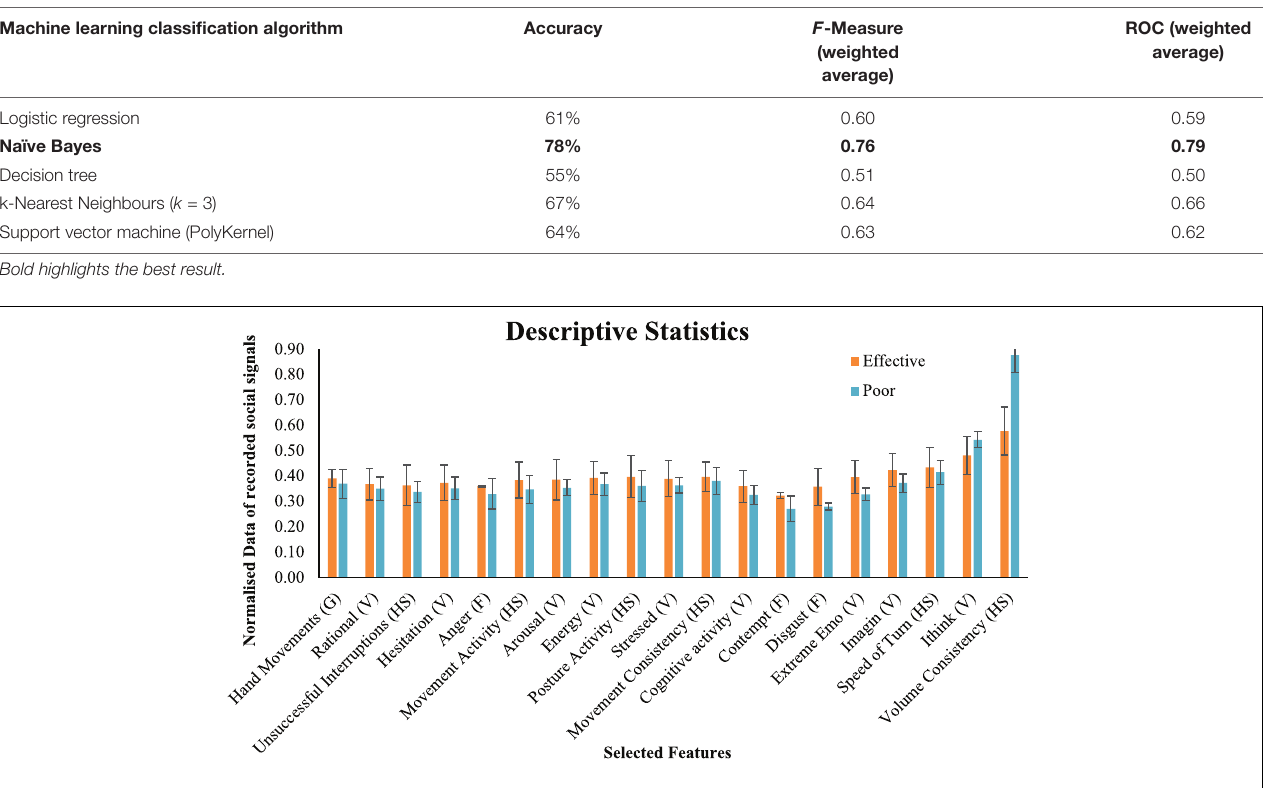
FIGURE 3 | Descriptive statistics for social signals. HS, honest signals; F, facial expression; V, vocal behaviour; G, gestures. The normalised data is the data from social signals captured by the automated technology.